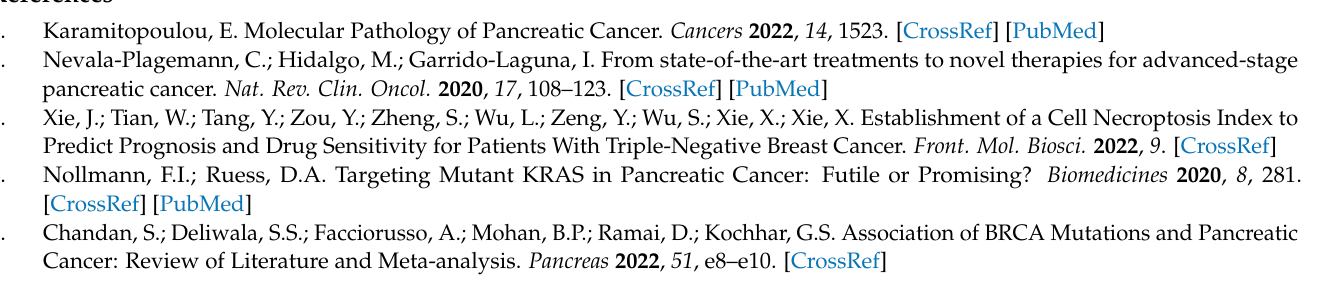
Figure S3: Expression analysis of IRGPI genes. Figure S4: Correlation between the risk score, IRGPI genes, and driver mutation